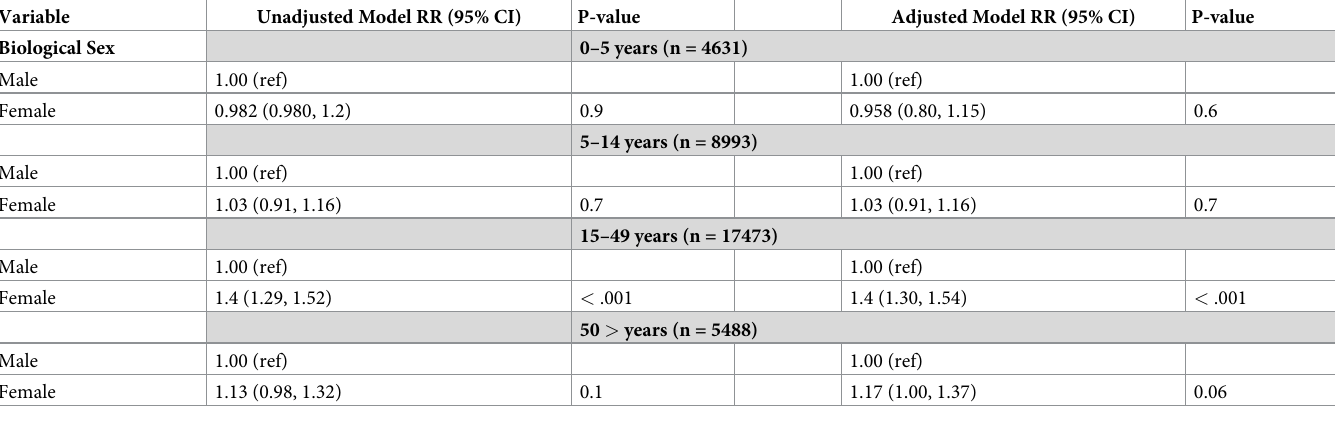
Table 3. Crude and adjusted risk ratios of the association between biological sex and ITN use by household members in eastern Myanmar stratified by age groups, 2013 (n = 36585).